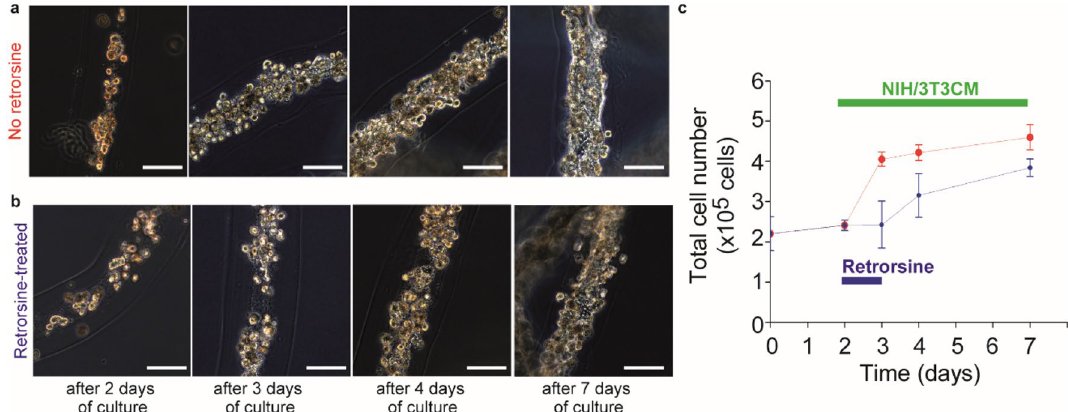
Figure 5. Proliferation of primary rat hepatocytes after 24-h treatment of retrorsine in cell fibers. ( a , b ) Representative dark-field images of primary rat hepatocytes cultured in cell fibers (n = 5 for each group) for 2 days, 3 days, 4 days, and 7 days using 3T3CM. Cell fibers encapsulating primary hepatocytes were divided into two groups: ( a ) in one group the hepatocytes were not treated with retrorsine, ( b ) while in the other group they were treated with retrorsine for 24-h after 2 days of culture. Scale bars; 100 µm. ( c ) Time course of total cell number of primary rat hepatocytes cultured in cell fibers using 3T3CM either ( c ) with or ( d ) without 24-h retrorsine treatment after 2 days of culture (n = 5 per data point). Error bars denote mean ±